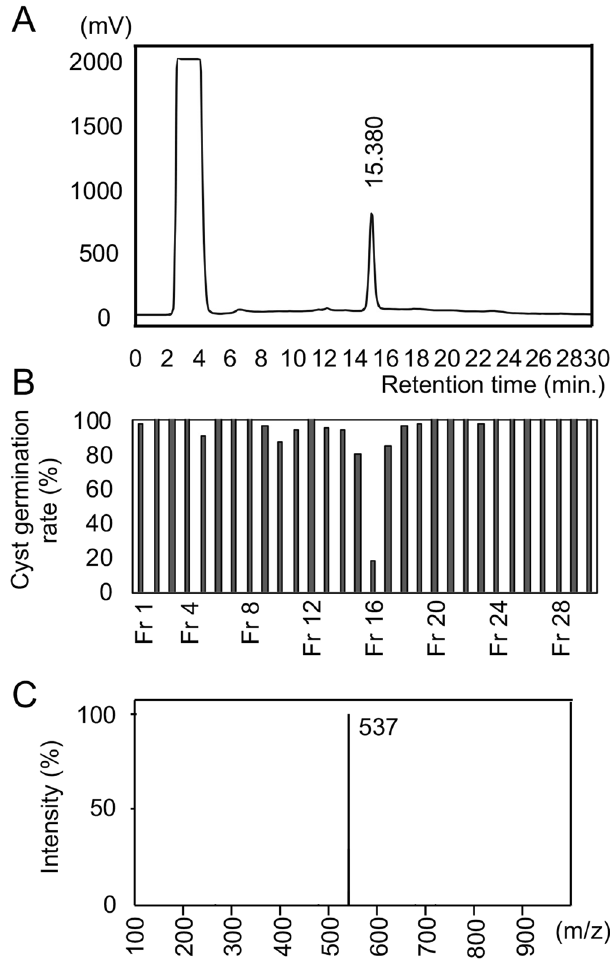
Figure 1. Activity and LC–MS data of purified sample A. ( A ) HPLC profile indicating that the bioactive fraction was at 15.38 min. ( B ) Effect of fractions on Ph. infestans cyst germination, showing that the peak from panel A contains the inhibitor. The cyst germination rate under the control condition was set as 100%. ( C ) LC– MS data of Sample A purified from the isolated strain, Streptomyces sp. no. 750 ( m / z =